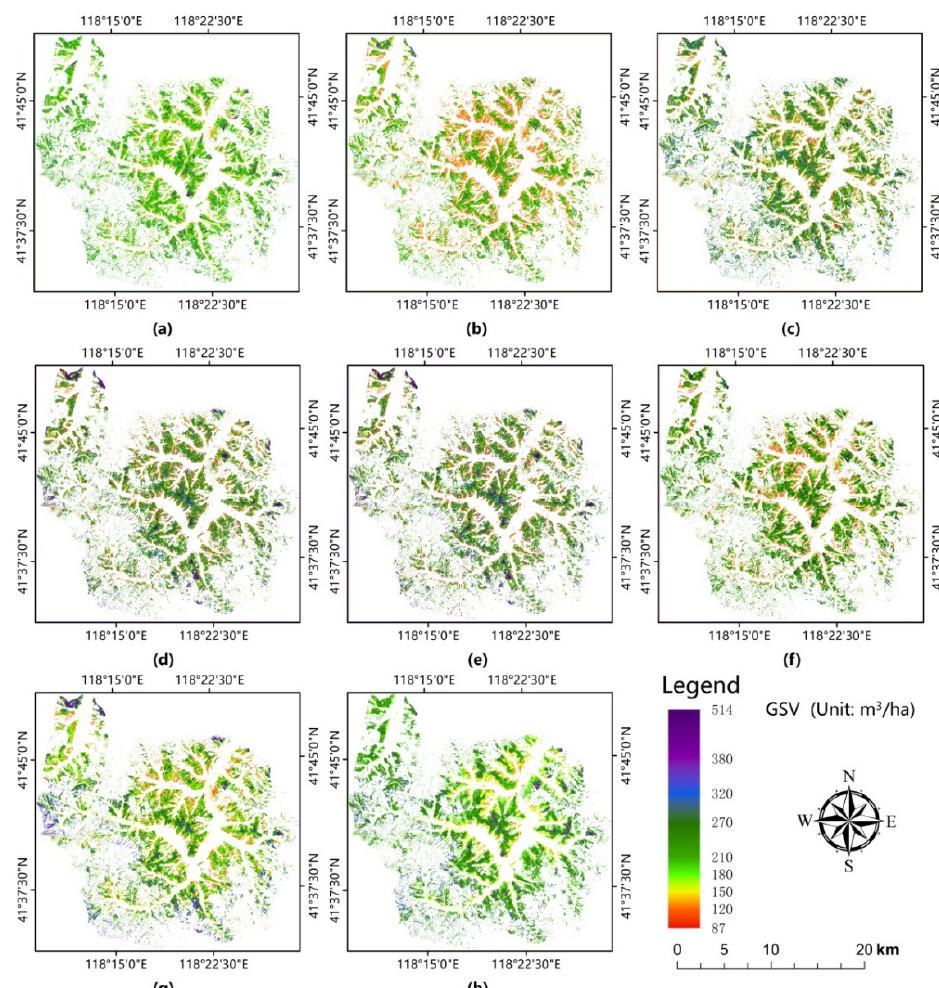
Figure 8. GSV distribution maps of coniferous plantations in the study area using the combined GF-2 and Sentinel-2 image dataset estimated by the ( a ) RF-RFR, ( b ) SRF-RFR, ( c ) (KNN-FIFS)-KNN, ( d ) (DC-FSCK)-KNN, ( e ) AFCO-KNN, and ( f ) AFCO-RFR methods. ( g , h ) GSV distribution maps estimated by the AFCO-RFR models based on GF-2 and Sentinel-2 images alone, respectively.